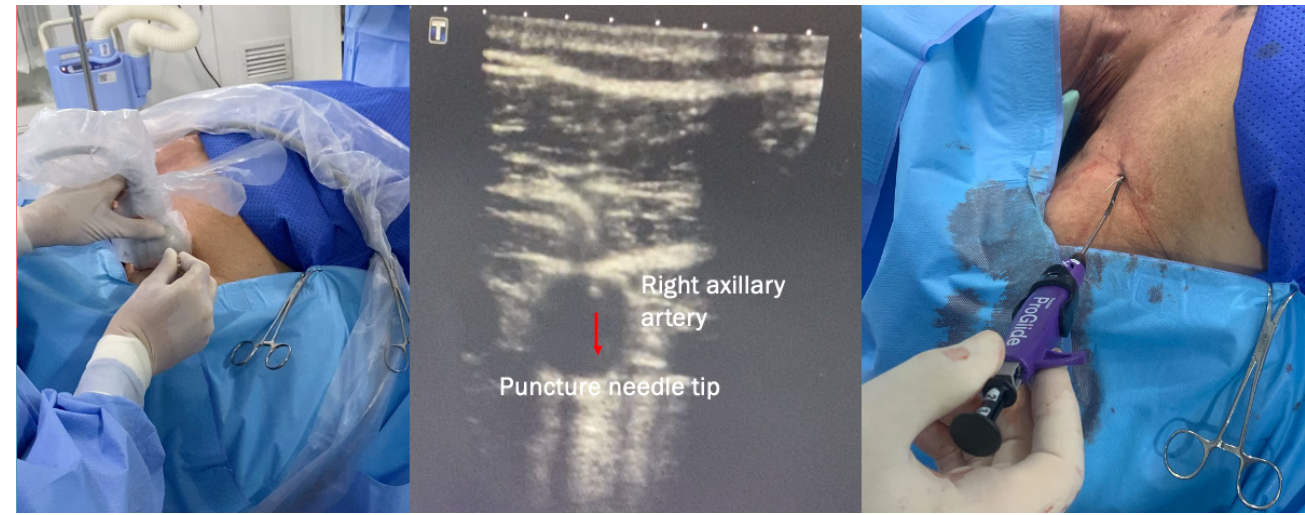
Fig. 2 - Ultrasound-guided right axillary artery puncture and Perclose/ProGlide™ insertion.